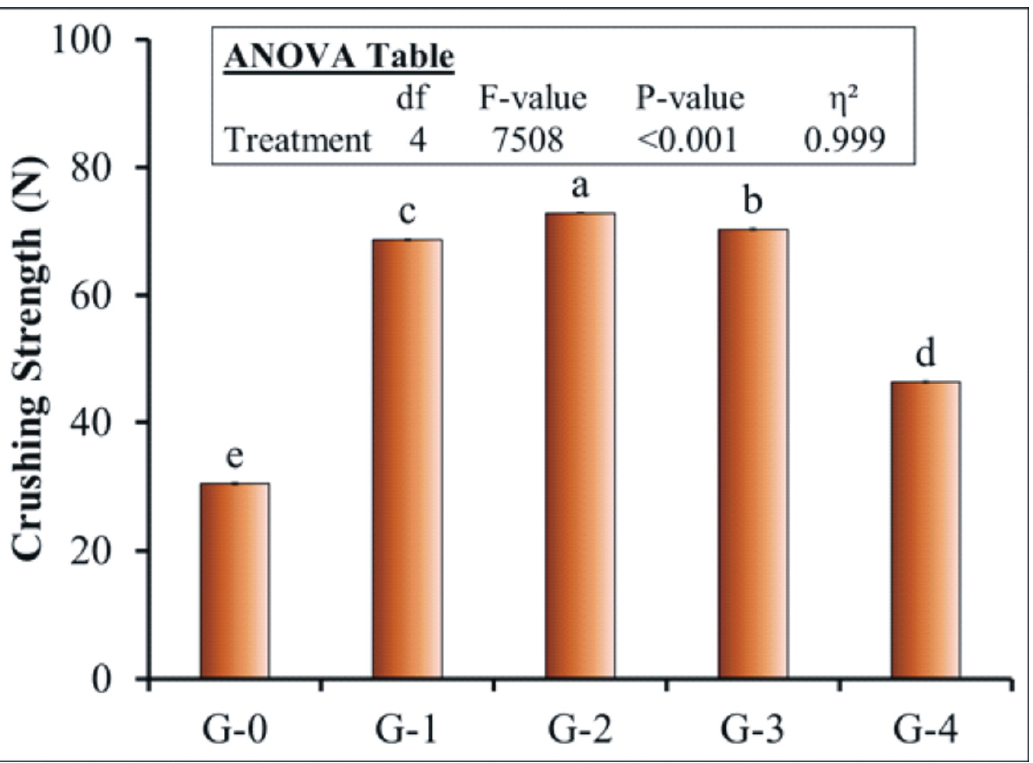
Figure 4. Effect of coating on crushing strength of granular urea. Abbreviations of different treatments can be seen in the caption of Figure 1. Small letters on bars indicate the difference among treatments at 5% probability level. Error bars show the standard error of the mean (n = 4). Insets in the figure represent outcomes of the analysis of variance (ANOVA).